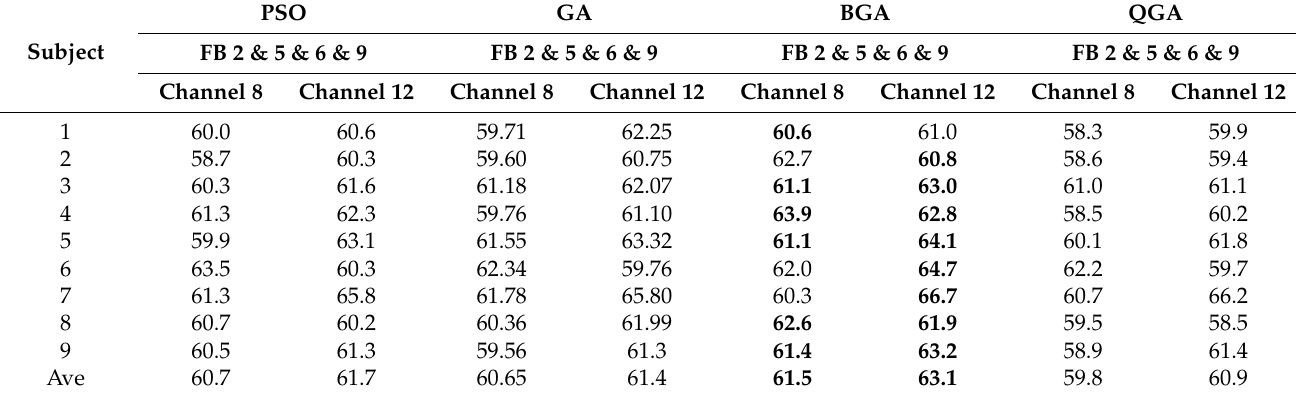
Table 11. Feature selection accuracy of PSO, GA, and BGA with 100 features, FB2 & 5 & 6 & 9, and ELM for 100 iterations.